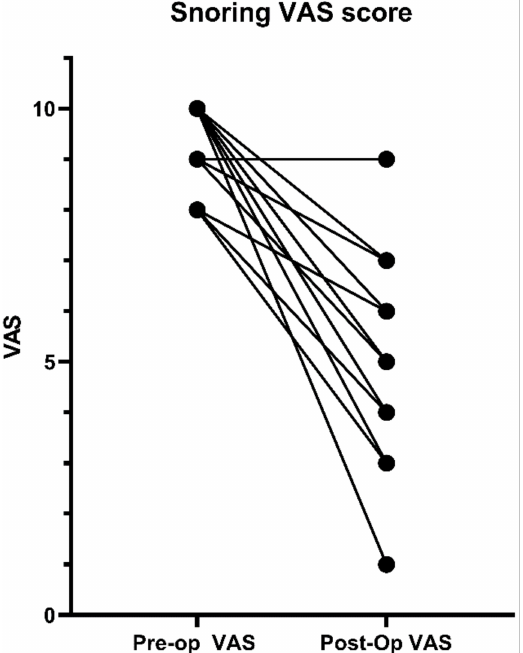
Figure 3. Pre- and post-operative comparison of the reported visual analog scale score for snoring loudness and inconvenience by the patients.